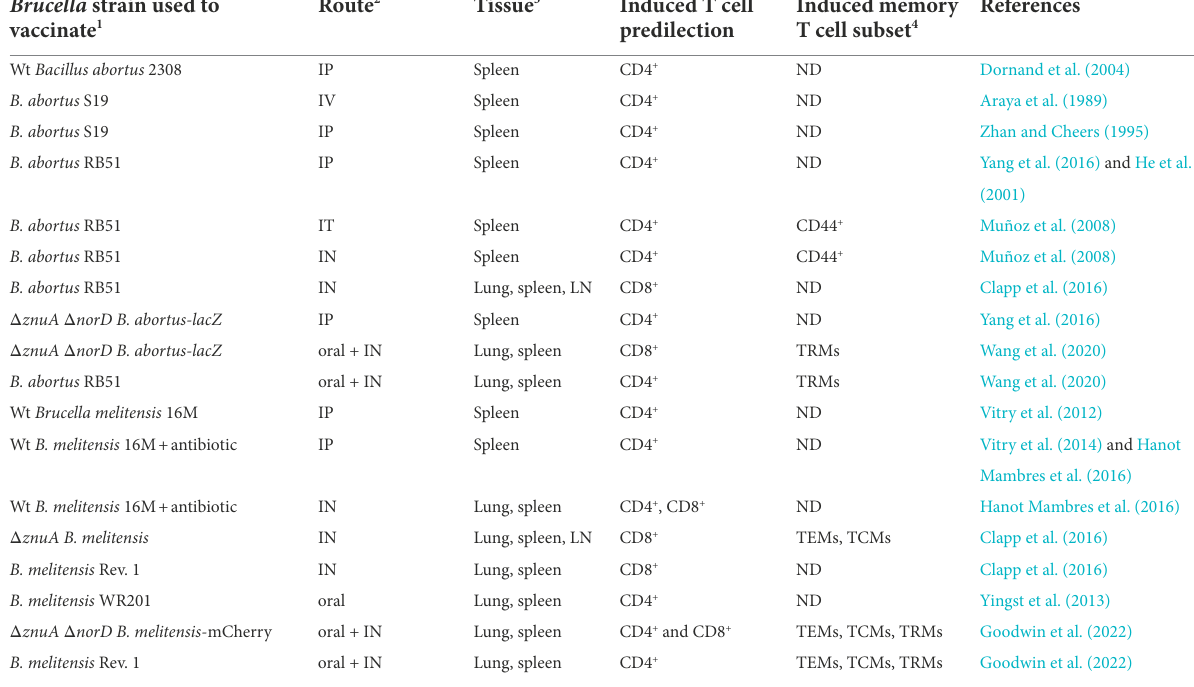
TABLE 1 Both route and Brucella strain used for vaccination influence T cell responses. Brucella strain used to vaccinate